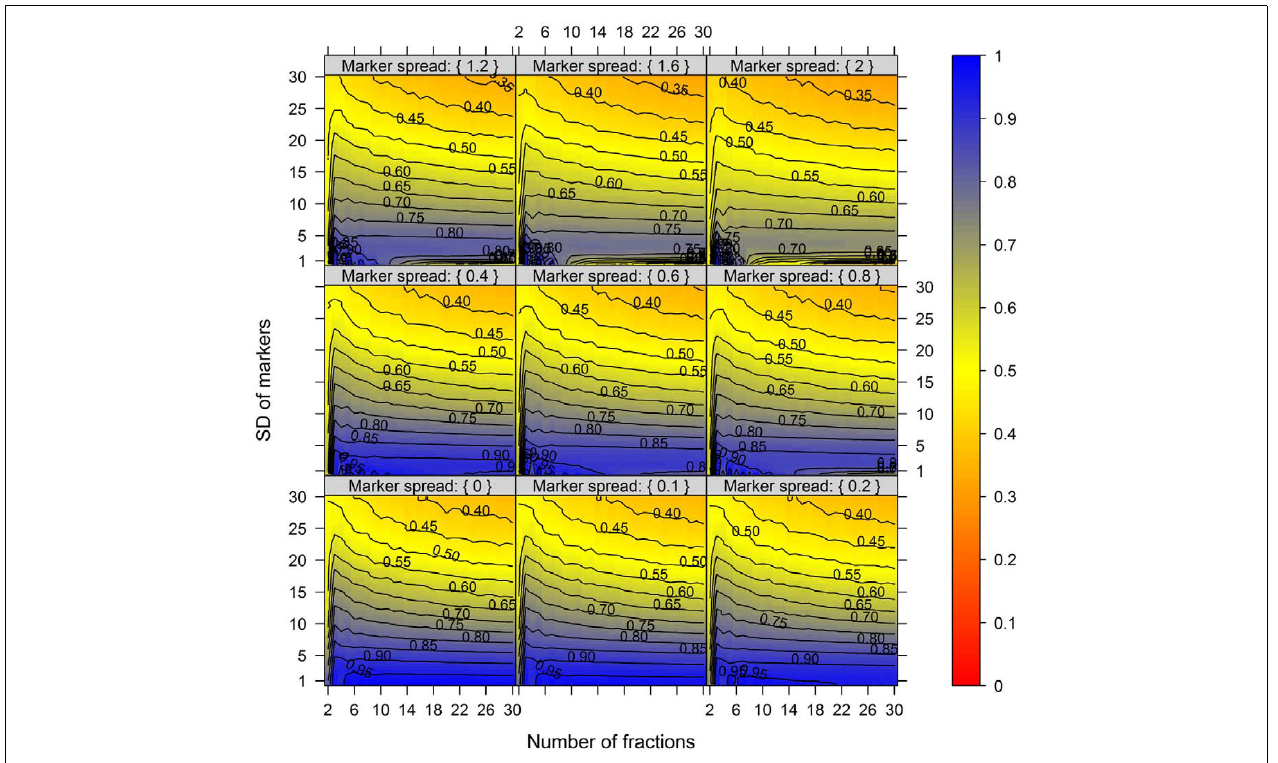
FIGUREA3 |The cluster validity in dependence of the number of collected fractions, the SD of markers, and the marker spread for the four-compartmental model. The cluster validity index is depicted for 4 compartments each represented by 3 markers. For further details see FigureA2 .